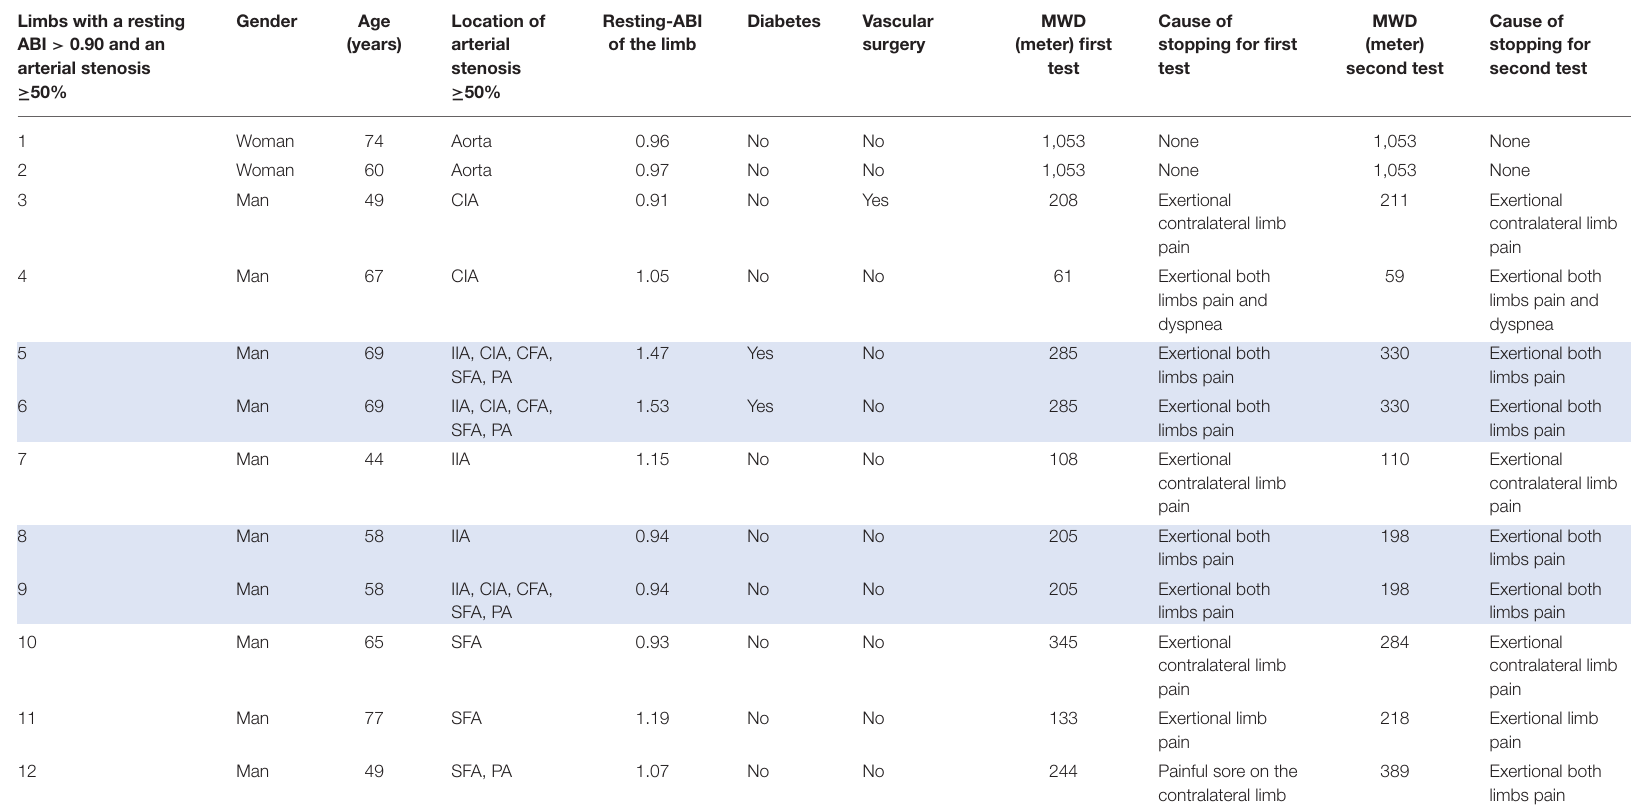
TABLE 4 | Characteristics of patients of which there were discrepancies between the American Heart Association (AHA) post-exercise criteria (negative for the diagnosis) and the combination of post-exercise ankle-brachial index (ABI) with Exercise oximetry (TcPO2) (positive for the diagnosis). Limbs with a resting ABI > 0.90 and